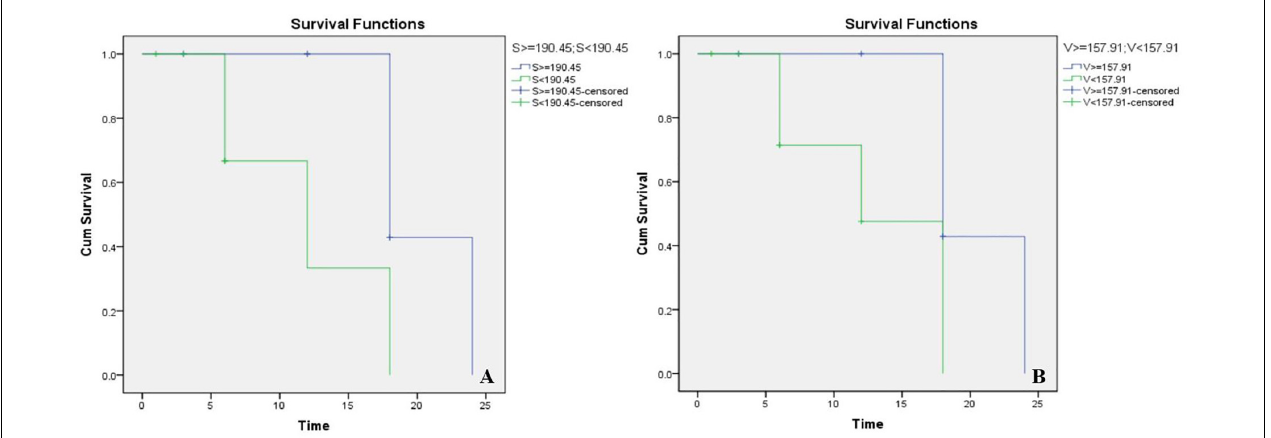
FIGURE 3 | Kaplan-Meier survival chart of different lumen surface areas (A) and volumes (B) . S, surface areas; V,